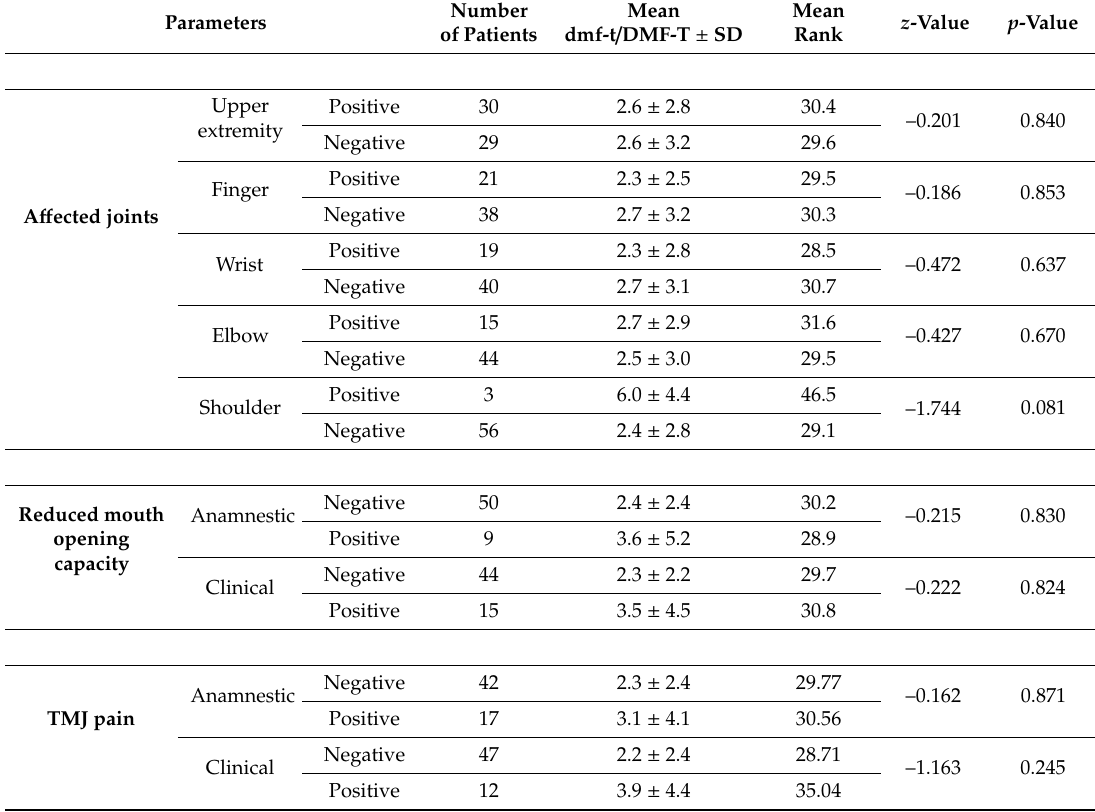
Table 3. Association of a ff ected joints, reduced mouth opening capacity and pain with dental findings (dmf-t /